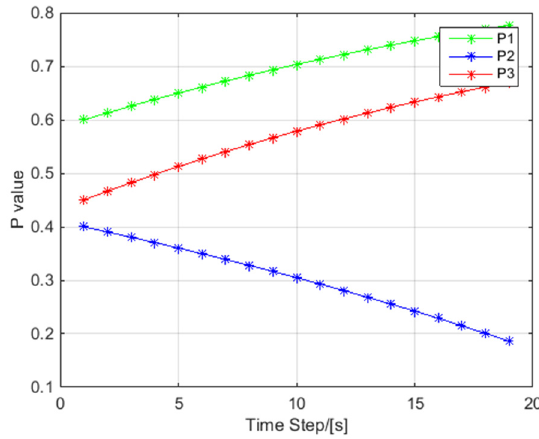
Figure 13. P value of three UAVs.